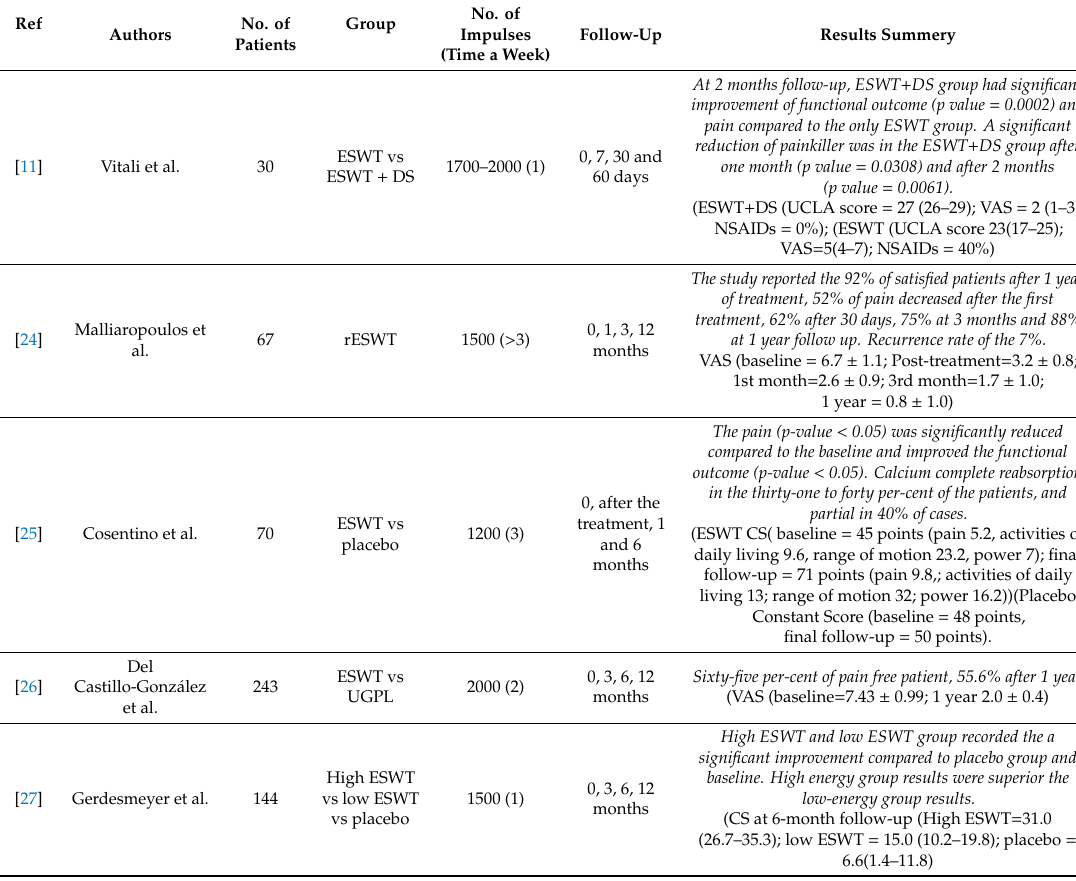
Table 1. The main findings of shoulder tendinopathies included case-control and cohort